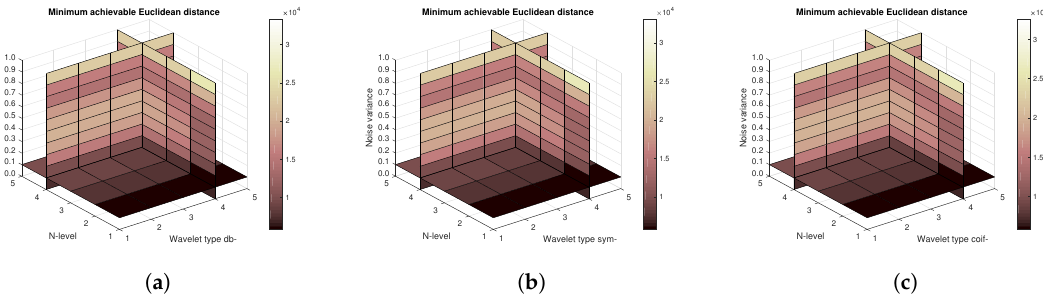
Figure 13. Mean achievable Euclidean distances for 60 MRI images with use of three mother wavelet families—from left Daubechies ( a ), Symlet ( b ) and Coiflet ( c